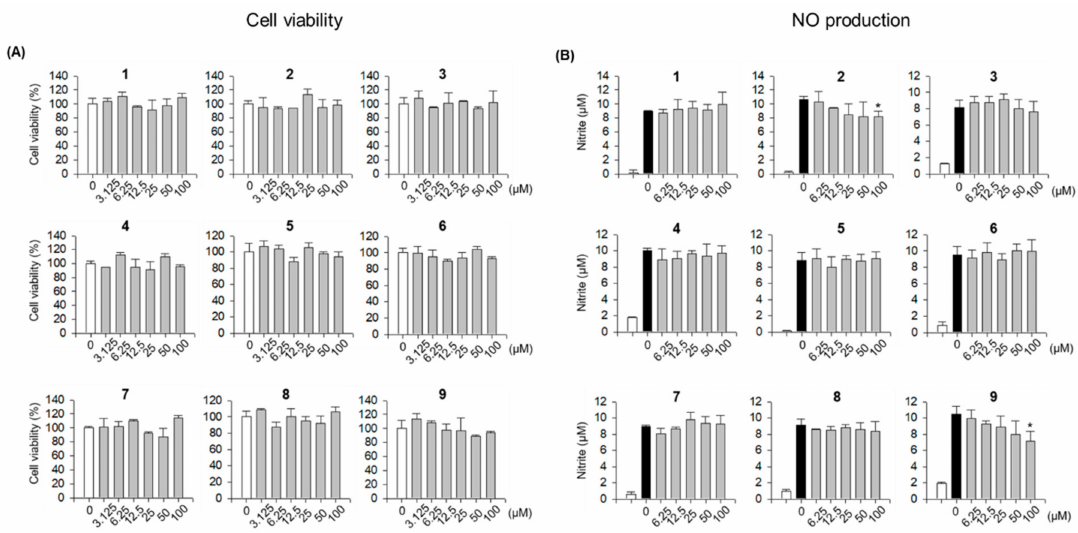
Figure 6. ( A ) Cell viabilities of the isolated compounds ( 1 – 9 ) measured using the EZ-Cytox cell viability assay. ( B ) Inhibitory e ff ects of compounds 1 – 9 on LPS-induced NO production in RAW 264.7 cells. Cell viability data represent relative cell viability compared to that of the untreated group (100%). NO assay data represent NO production levels calculated by applying absorbance values at 540 nm to a nitrite standard curve. p < 0.05 relative to the LPS-treated control